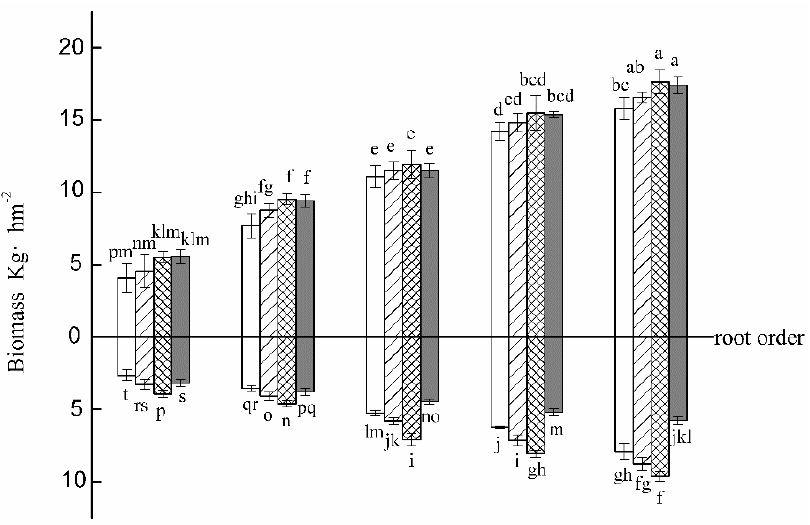
Figure 6. The effect of crop tree management on the root biomass at different distances from the target Pinus massoniana . The X axis is the first to the fifth root order. The bars above the X axis represent the crop trees and the bars below the X axis represent the noncrop trees. I, II, III, and IV represent the distance of fine roots to the target tree at 0–0.5, 0.5–1, 1–1.5, and 1.5–2 m. Each bar represents the mean ± SD with three replicates. Different letters above or below each bar indicate significant differences among groups compared by Fisher’s LSD test at p < 0.05. Table 2. Fine root biomass in each soil depth of crop trees.